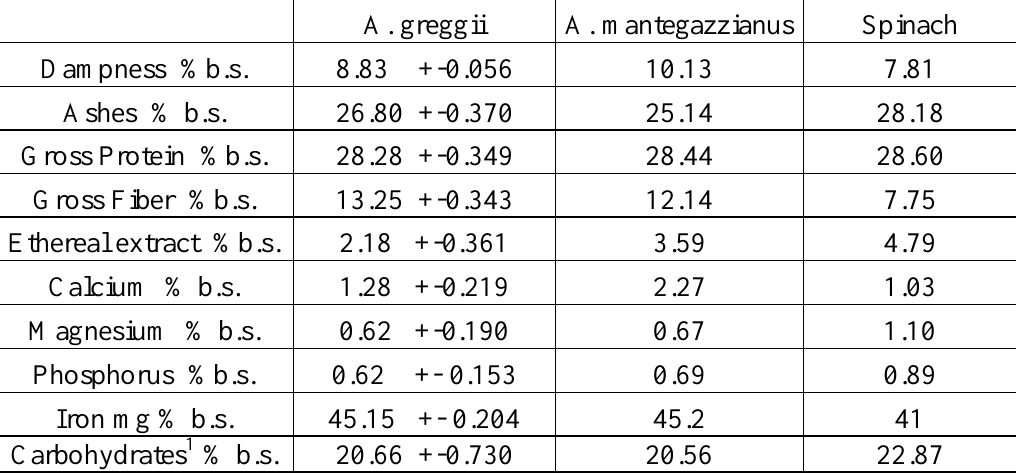
Table 1. Proximal Chemical Composition of the tested A. greggii, confronted with A.mantegazzianus and spinach.